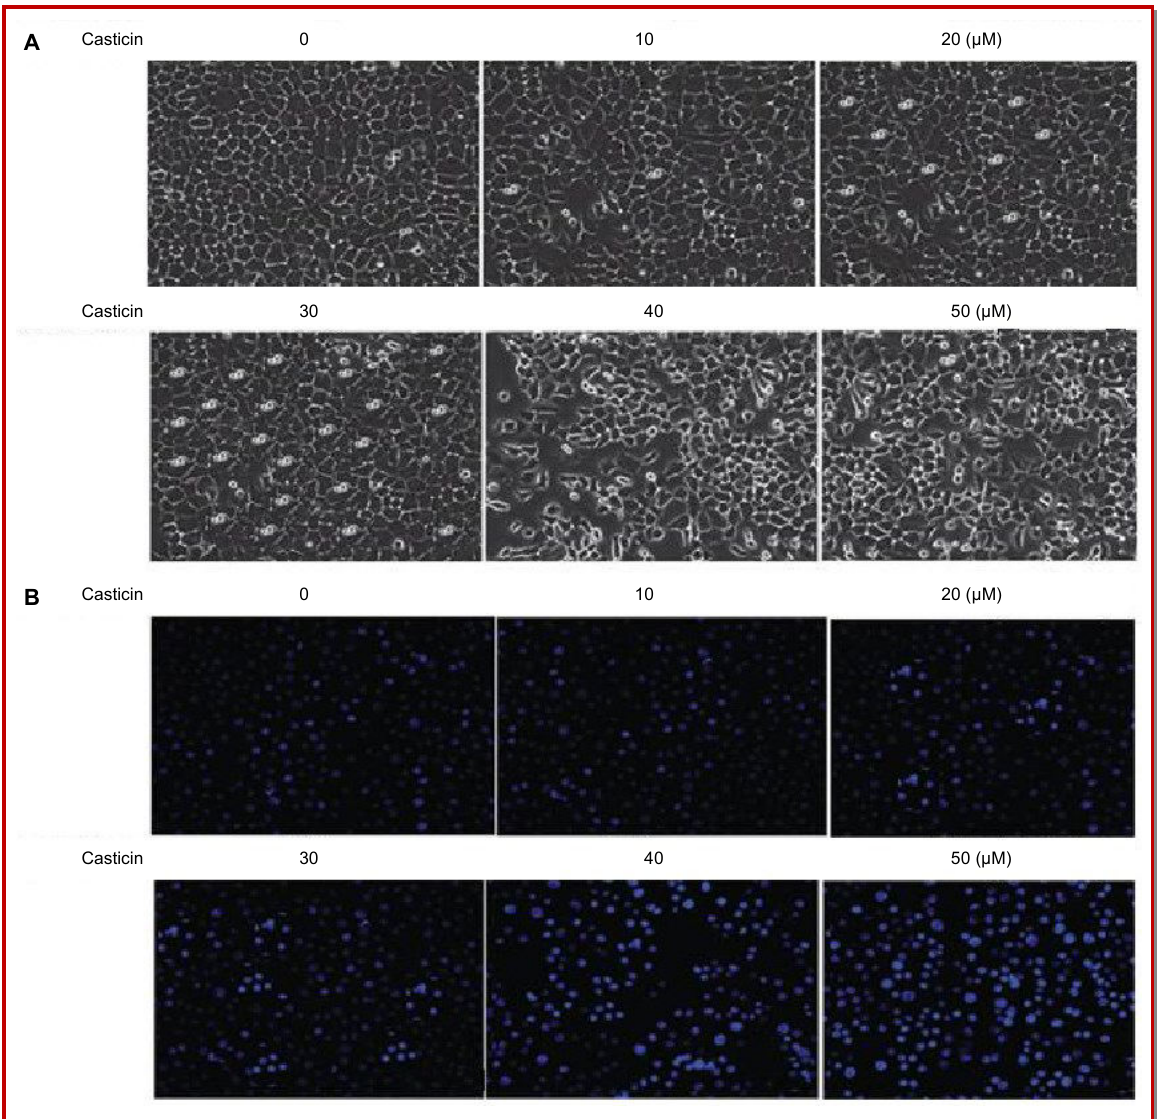
Figure 2: Casticin induced morphological alterations in TE-1 cells. The cells were treated with 10, 20, 30, 40 and 50 µM/L doses of casticin or left untreated as control for 48 hours (A) and subjected to Hoechst 33258 staining (B). The cells were then observed under light microscope to examine the